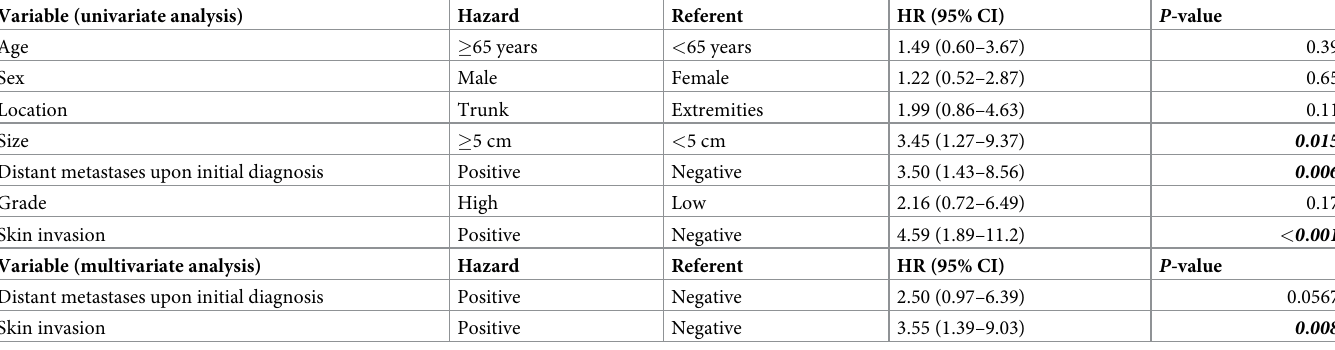
Table 3. Cox proportional hazards analysis for overall